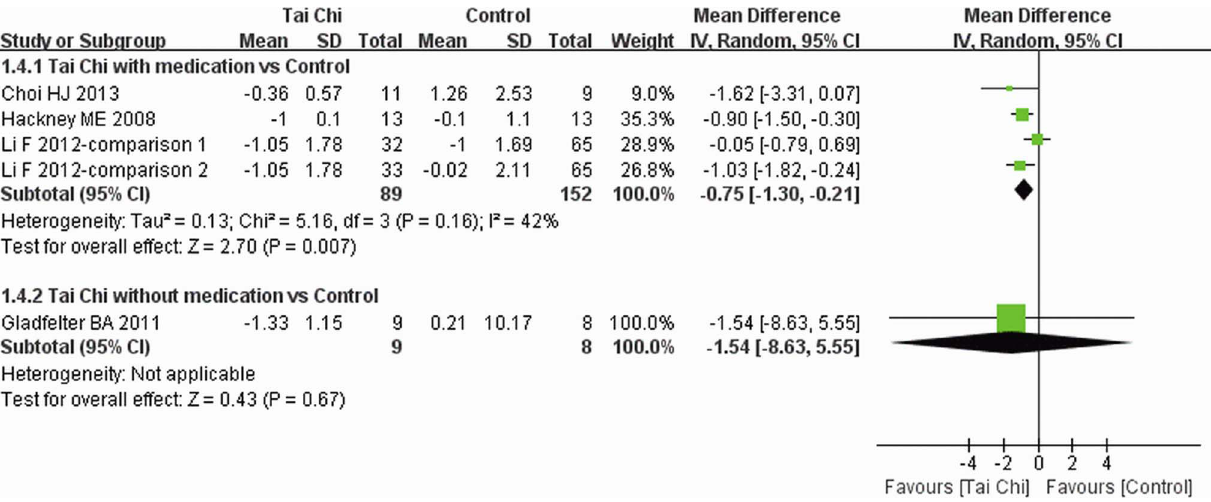
Figure 6. The effect of Tai Chi on TUG. Subgroup analysis was performed according to whether or not medications were included in the intervention. A random model was used to address the high heterogeneity. TUG, Timed Up and Go test.